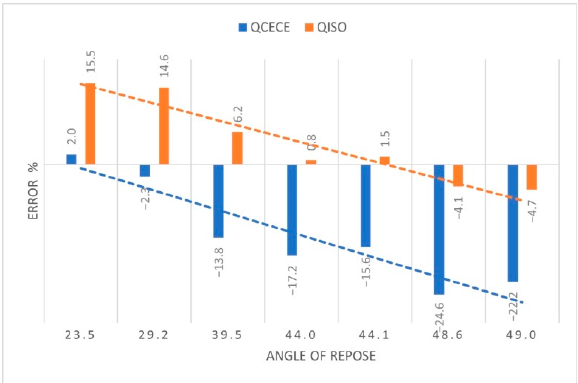
Figure 6. Influence of the angle of repose on the excavator productivity calculation error.